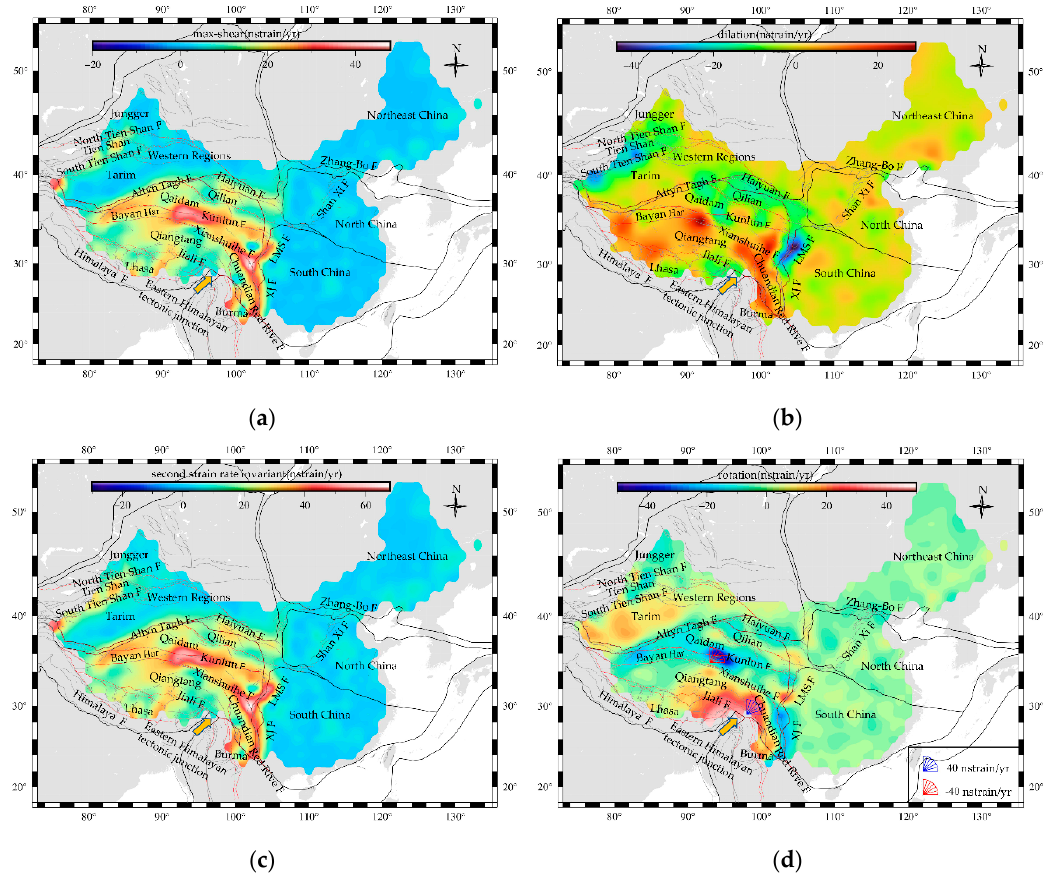
Figure 4. Continuum deformation field of continental China derived from interpolation of velocities (the black line is the boundary line of the first active block; the red line is part of the boundary line of the second active block; the gray lines represent the fault; Chuandian represents Sichuan-Yunnan; XJ F represents Xiaojiang fault; LMS F represents Longmen Shan fault):( a ) The maximum shear strain rate; ( b ) The dilation rate; ( c ) The second strain rate invariant; ( d ) The rotation rate(Assume that the clockwise rotation is positive).